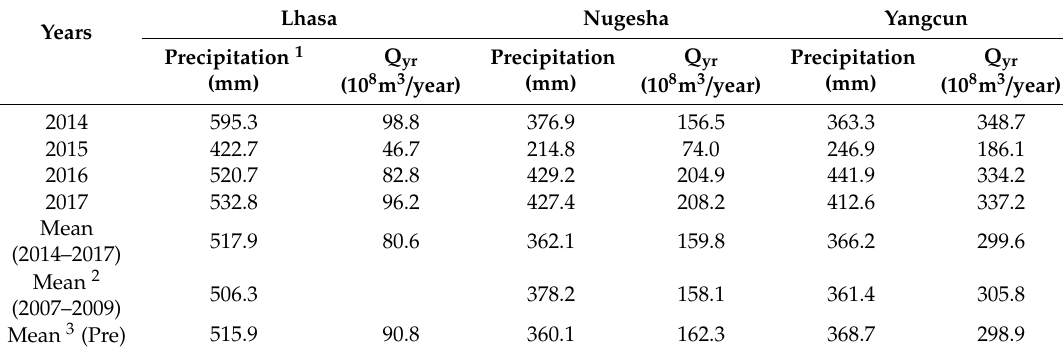
Table 2. Comparison of precipitation and streamflow with previous